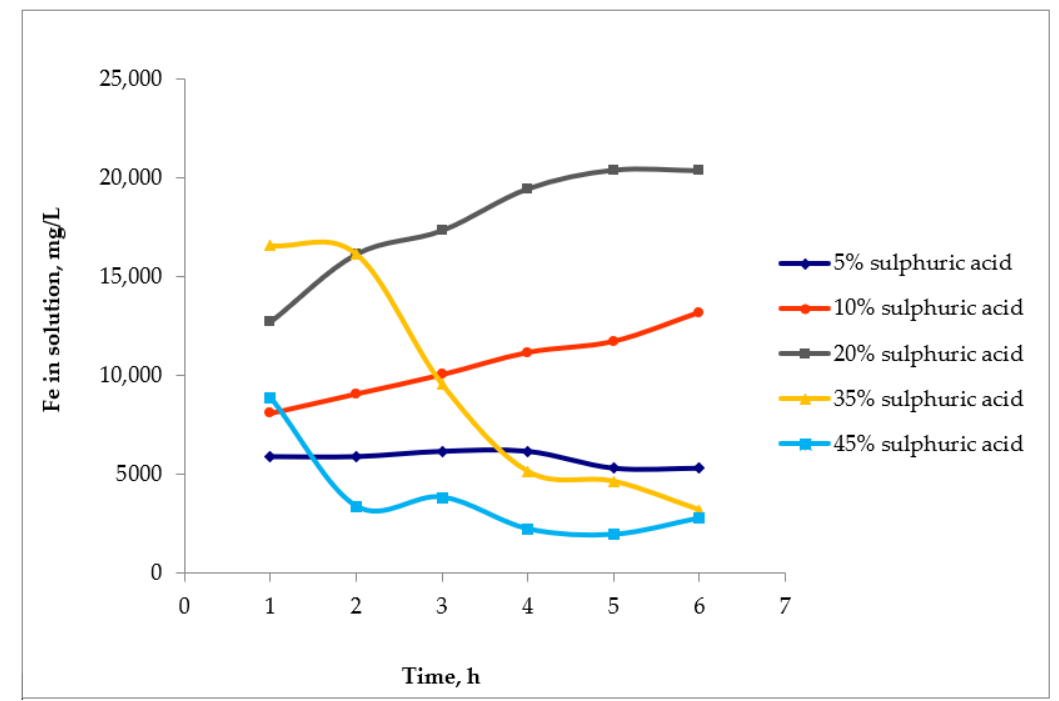
Figure 8. Iron concentration in solution at different intervals and different acid concentrations.